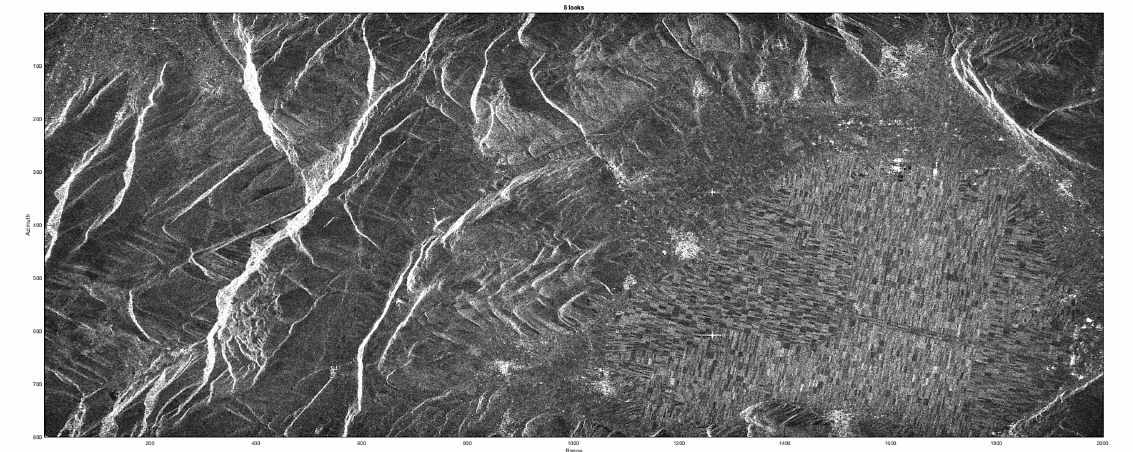
Figure 12. B-SAR focusing. Caramanico site, Fucino Valley, Italy.